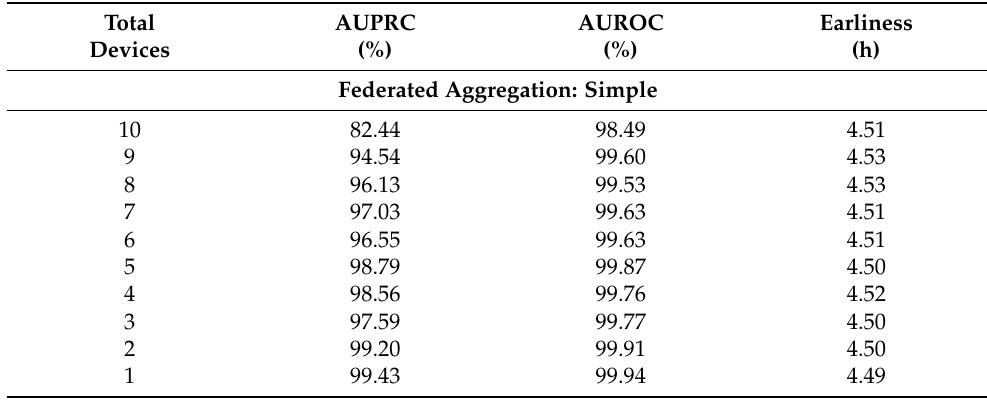
Table 11. Evaluation results using multi-modal (both clinical-text and non-text ) input features in a federated learning setting using a different number of Raspberry Pi devices.